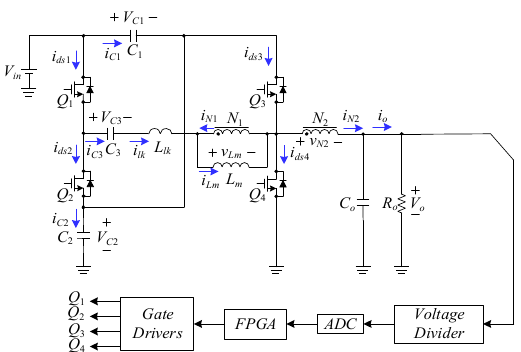
Figure 13. System configuration block diagram.